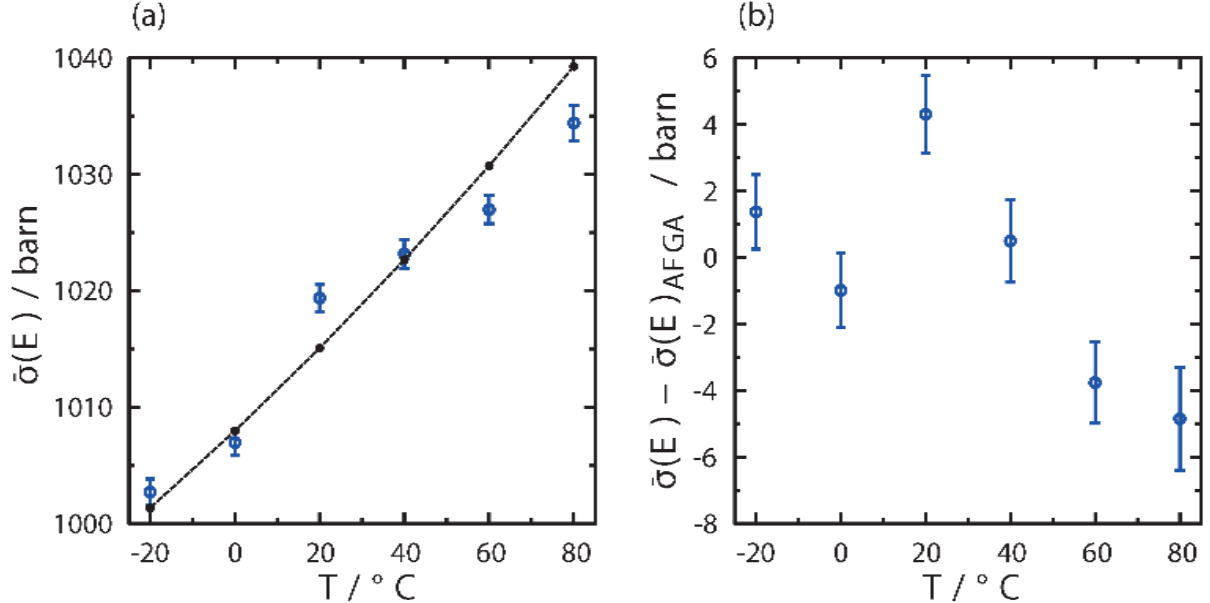
Figure 10. ( a ) The integrals, in the incident neutron energy range between 2.6 and 10 meV, of the total neutron scattering curves, for the sample of rice pasta with the water content 0.1069 g/g d.m. between − 20 and 80 ° C together with the integrals of the predictions from the AFGA model. The integrals of the experimental data are shown as blue markers and the integrals of the AFGA model predictions as a dashed black line. ( b ) The difference between the integrals of the experimental total neutron scattering cross-sections and their counterparts resulting from the predictions of the AFGA model.